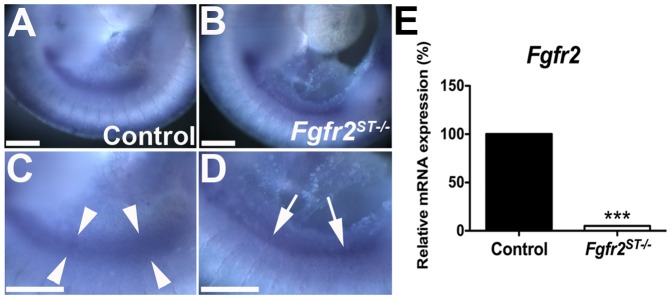
Expression of Fgfr2 in E10.5 in control and Fgfr2ST−/− embryos.
A,C. Lower power (A) and higher power (C) images show that control embryos have a wide band of Fgfr2 signal (between arrowheads) encompassing the Wolffian duct and surrounding stroma. B,D. Lower power (B) and higher power (D) images show that Fgfr2ST−/− embryos have a linear band of Fgfr2 expression in the Wolffian duct epithelium (arrows) and not in the surrounding stroma. E. Quantitative real-time PCR of FAC-sorted E10.5 Cag-Tbx18creTg/+ (Control) and Cag-Fgfr2ST−/− (Fgfr2St−/−) urogenital ridges confirms a dramatic decrease in Fgfr2 mRNA expression in mutant Tbx18cre expressing cells. Scale bars = 100 µm. ***p<0.001 vs. control embryos.